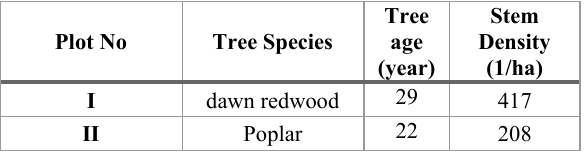
Table 2. The forest parameters of the two test plots The two plots were chosen to represent different